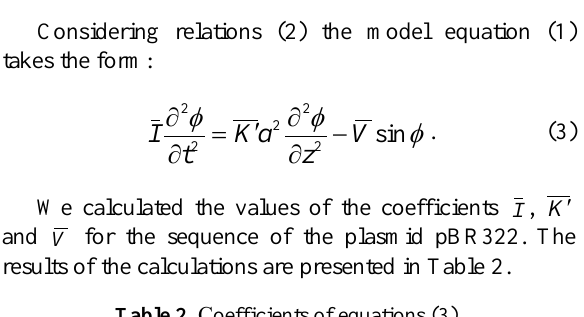
Table 2 . Сoefficients of equations (3).